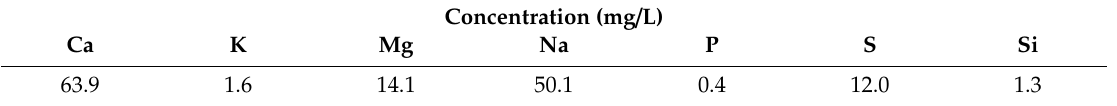
Table 2. Water analysis of greenhouse tap water, with values listed in mg / L.